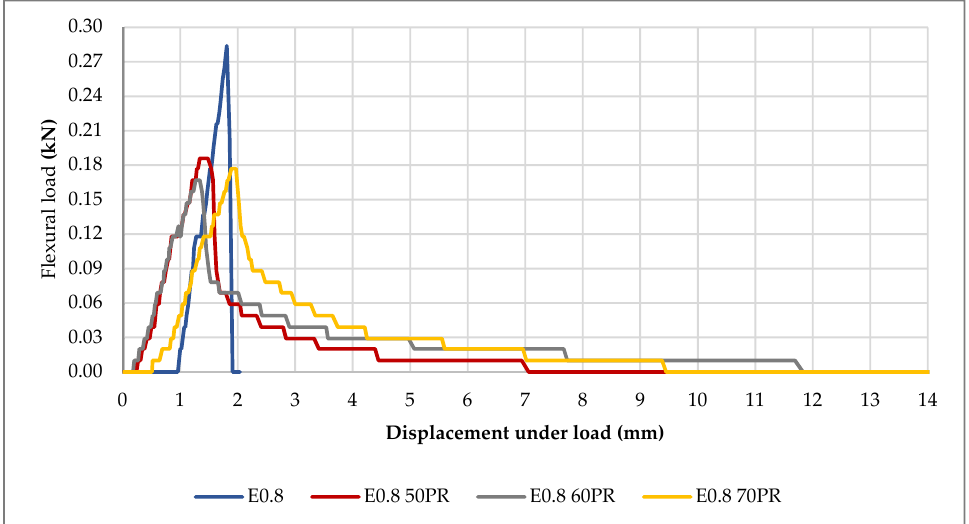
Figure 9. Load-displacement of the composites.